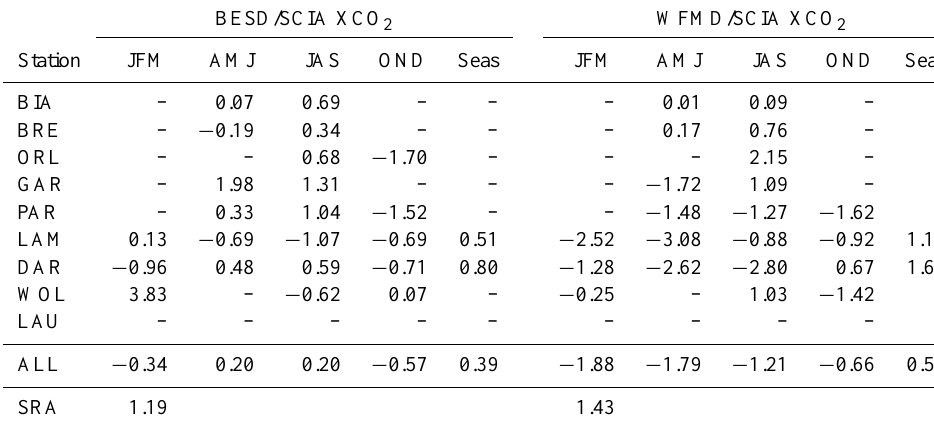
Table 4. BESD and WFMD XCO 2 seasonal mean bias, seasonality and SRA results. All results are in ppm units.